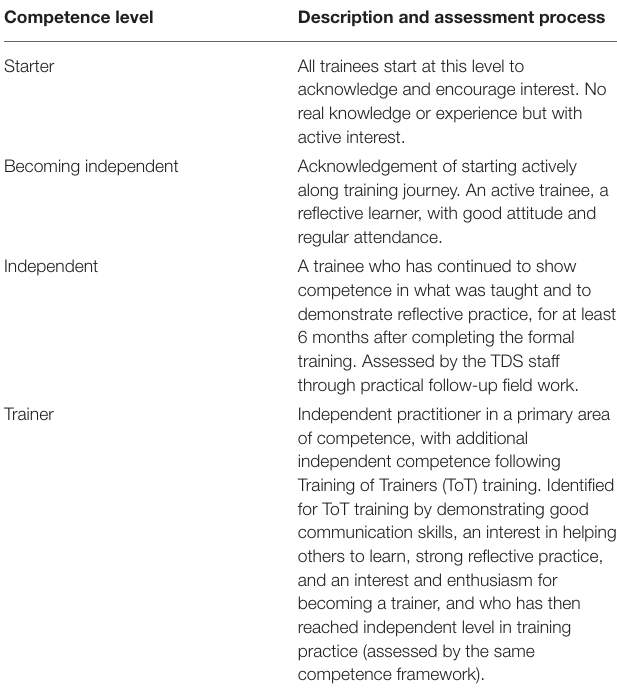
TABLE 2 | The Donkey Sanctuary general competence framework for trainees. Competence